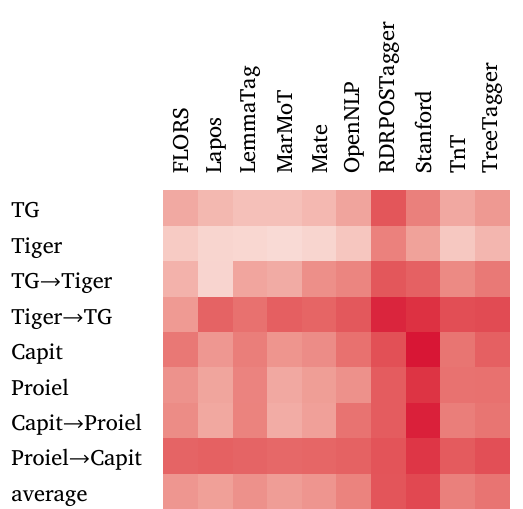
Figure 3: Heatmap depicting the degree to which accuracy drops when only out- of-vocabulary tokens are considered. The more saturated the cell color, the higher the delta